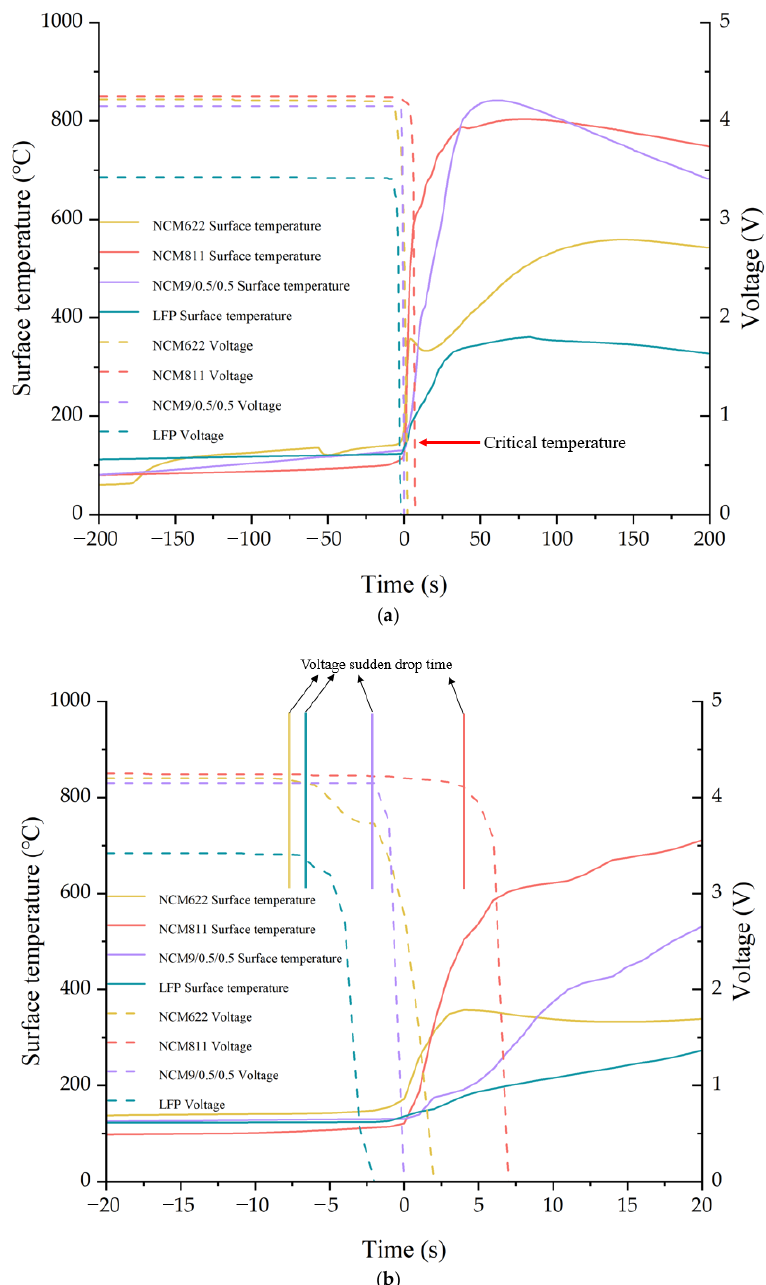
Figure 3. Battery surface temperature and voltage record. ( a ) Sample surface temperature and voltage changes. ( b ) Voltage change curve.